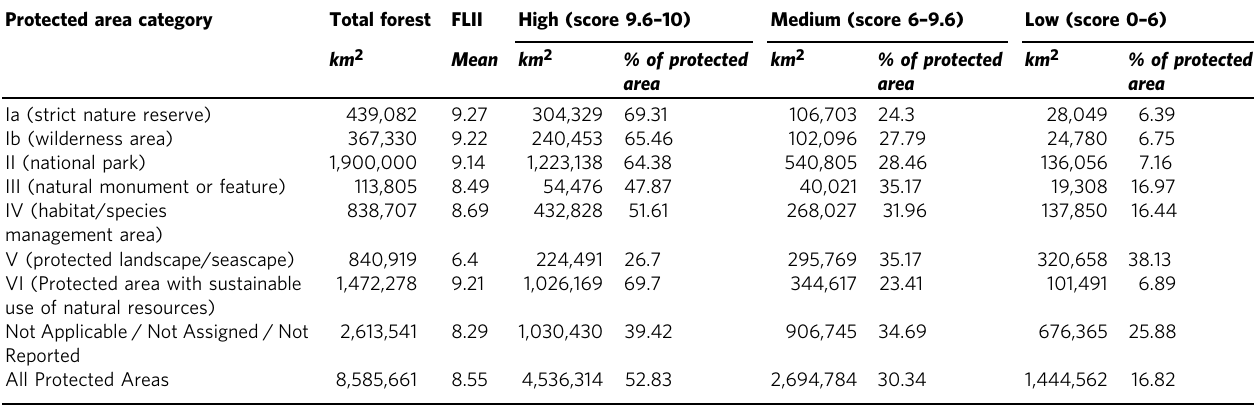
Table 2 Brief title: Forest Landscape Integrity Index scores for different types of protected areas. Protected area